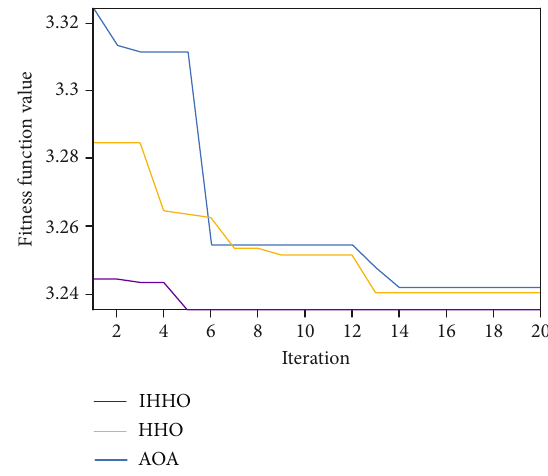
Figure 5: Comparison of fi tness function values.